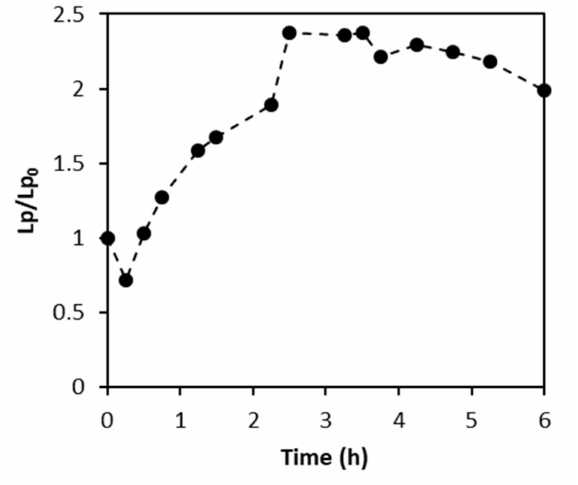
Figure 8. Relative permeability of the 200 Da ceramic membrane throughout the test with spent caustic